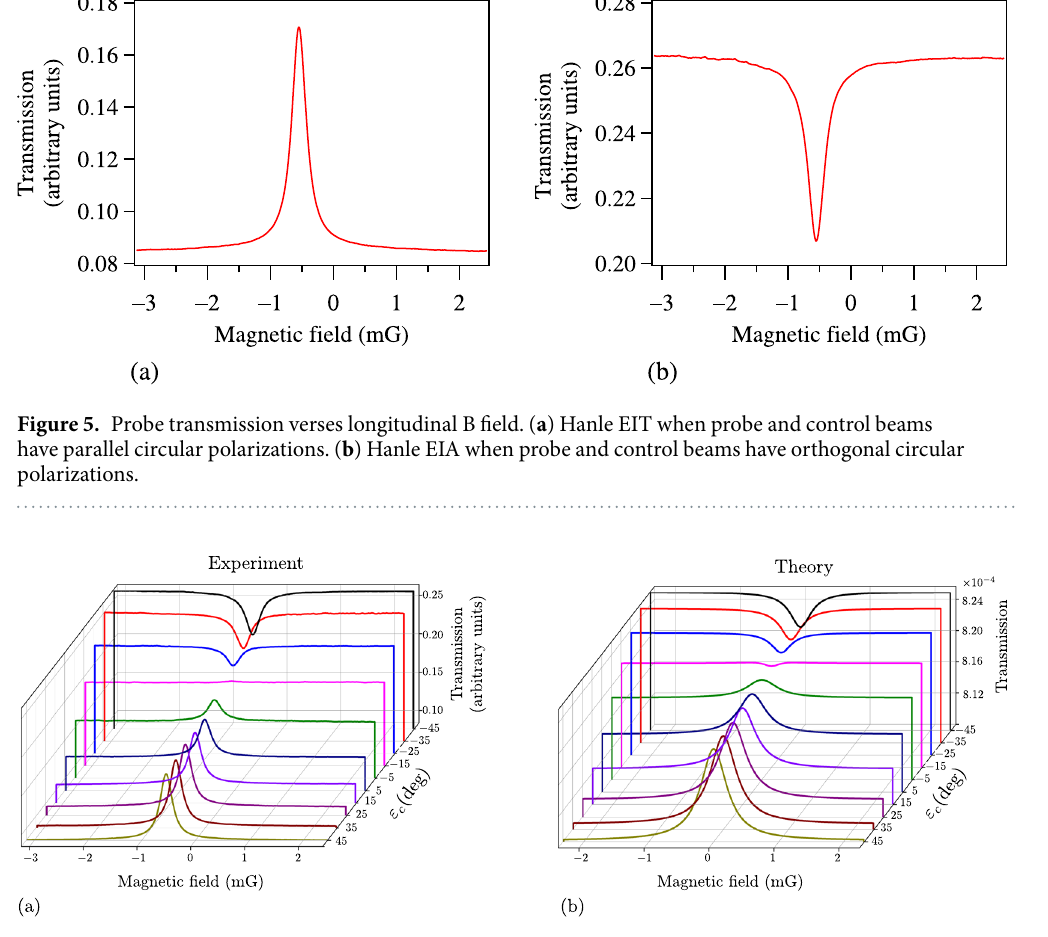
Figure 6. Transformation from EIT to EIA with change in control ellipticity. ε p is kept fixed at + 45°, while ε c is varied from + 45° to − 45°. ( a ) Experimental spectra. ( b ) Theoretical results; probe Rabi frequency Ω p is taken as 0.032 in units of Γ e ; control Rabi frequency Ω c for different curves is scaled from Ω p by the square root of the power ratio as used in the experiment; values of various relaxation rates are as follows: γ t 1 = γ t 3 = 0.012 Γ e , = 0.00003 Γ = 0.000005 Γ γ γ t 2 e , and w e ; transverse B field is taken to have a value of 0.3